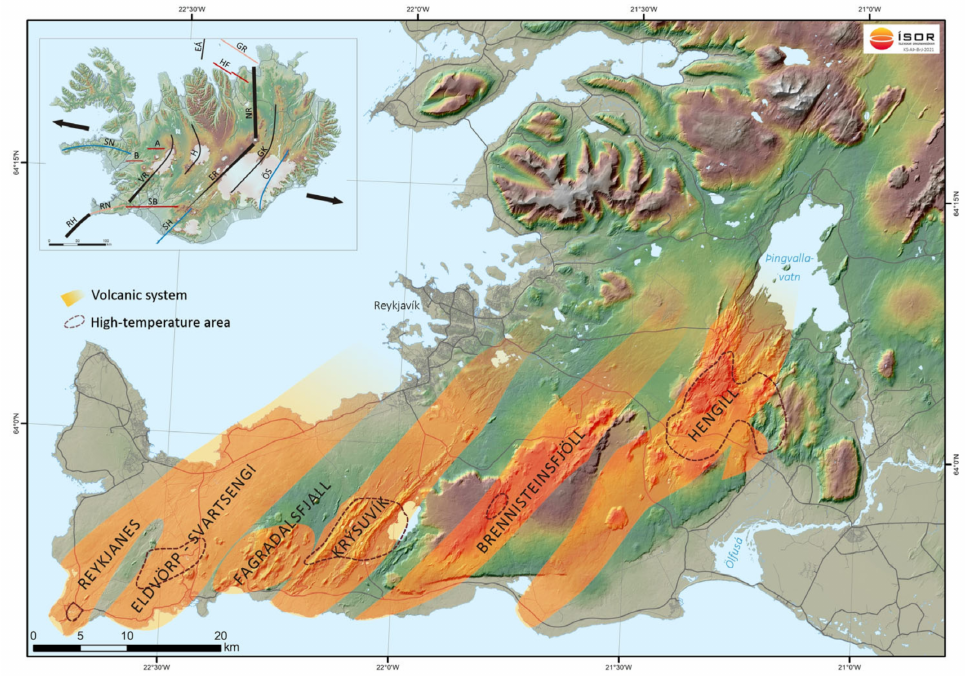
Figure 1. Geological map showing the location of the Reykjanes Peninsula and the fissure swarms in the area (image courtesy of Iceland GeoSurvey ( Í